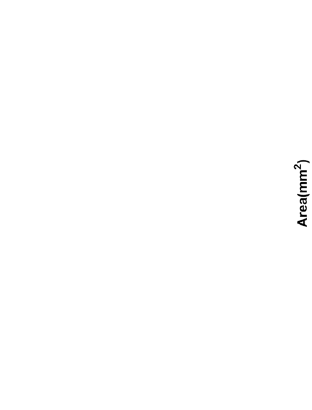
FIGURE 5 | Non-classical Bordetella species showed different abilities to resist predation by amoebae. The plaques formed on the lawn of Bordetella species were measured at various time points post inoculation of amoebae. Because the plaques formed on the lawn of B. pertussis , B. parapertussis hu and B. avium covered the entire plate before d15pi, the last data were recorded at days d9pi and d11pi, respectively. Non-classical Bordetella species, including B. petrii , B. avium , B. trematum , B. pseudohinzii , B. holmesii and B. hinzii , were tested in this assay. The data are based on 3 replicates in each group, error bars show the standard error of mean.